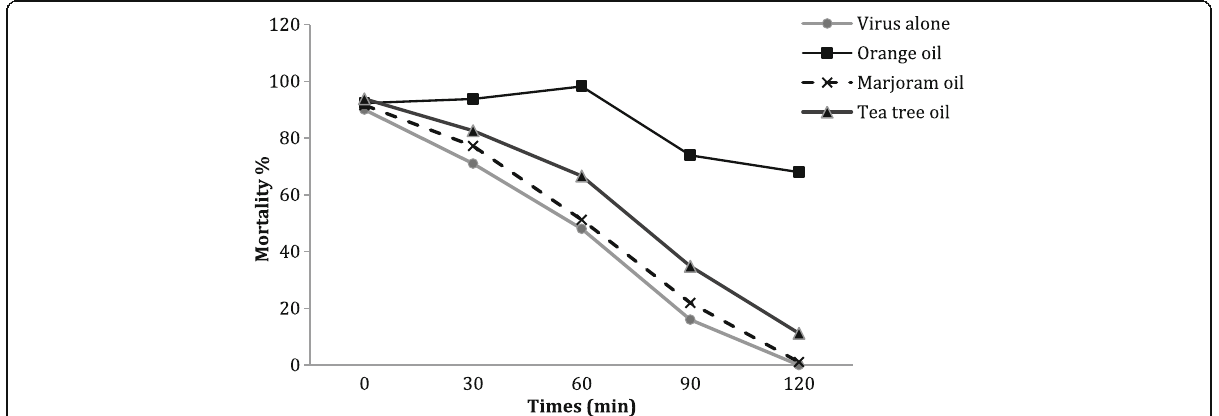
Fig. 1 Effect of UV irradiation on either Spli NPV or in combination with orange, marjoram, and tea tree oils